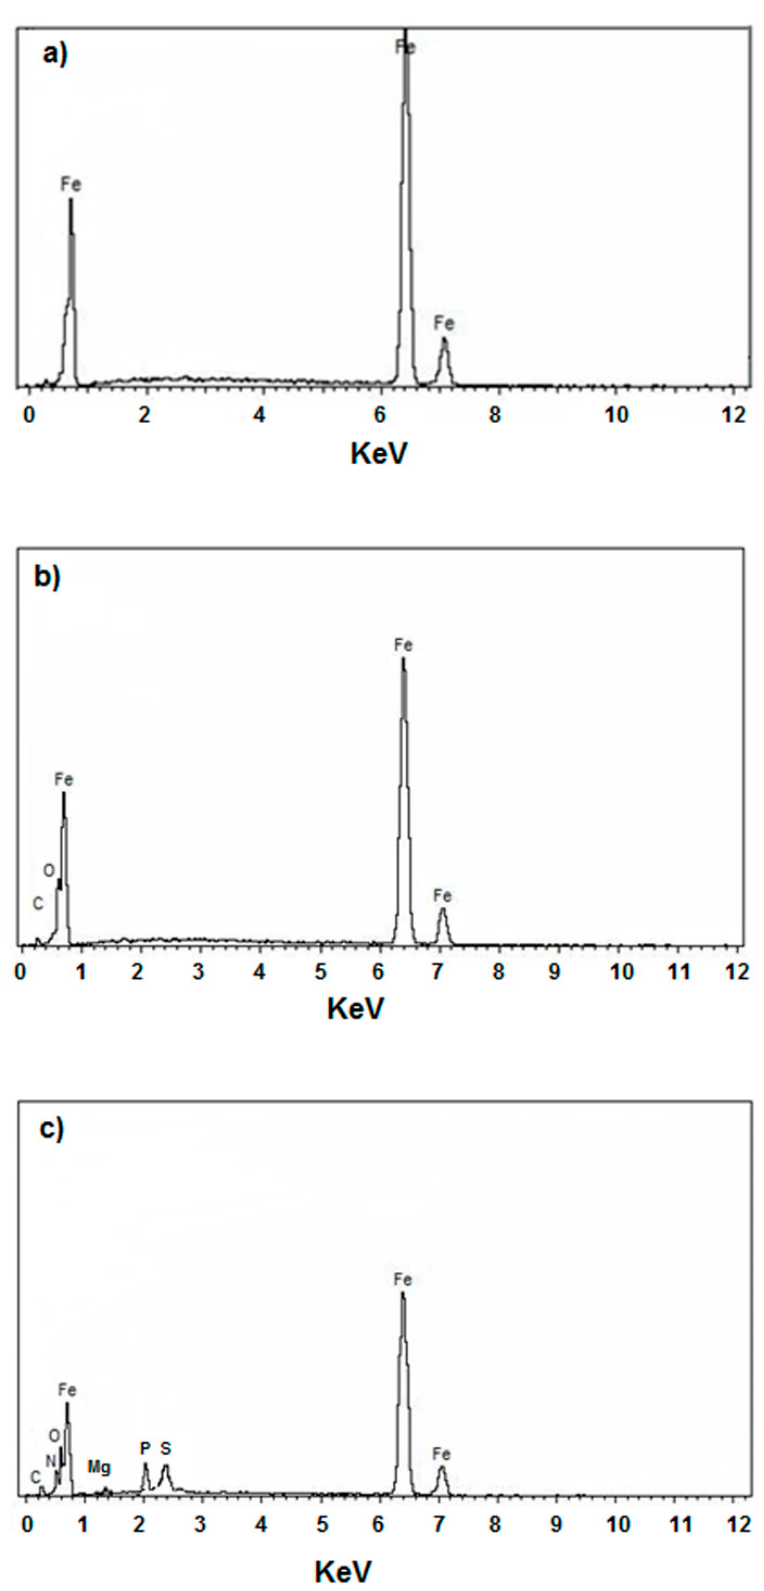
Figure 10. EDX spectra of white, marked areas of ( a ) polished, ( b ) uninhibited (blank), and ( c ) inhibited (4.50 × 10 − 4 mol L − 1 corrosion inhibitor 7 ) mild steel